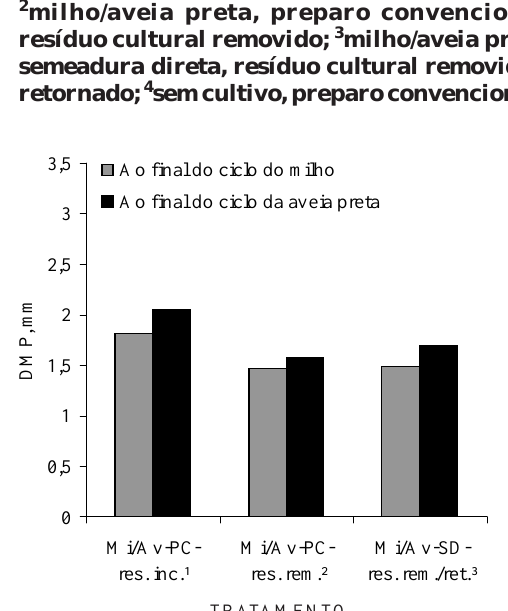
Figura 2. Valores médios do diâmetro médio